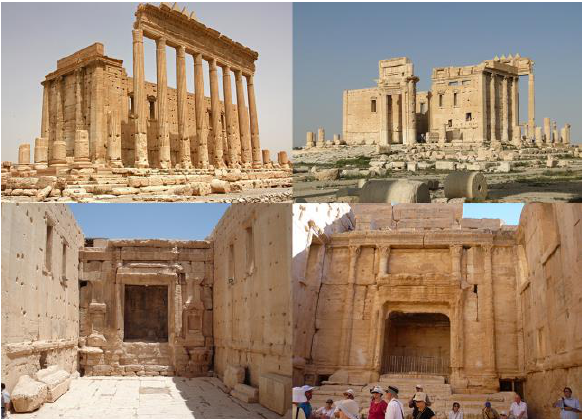
Figure 1: some of the open domain touristic images of the temple of Bel used for the